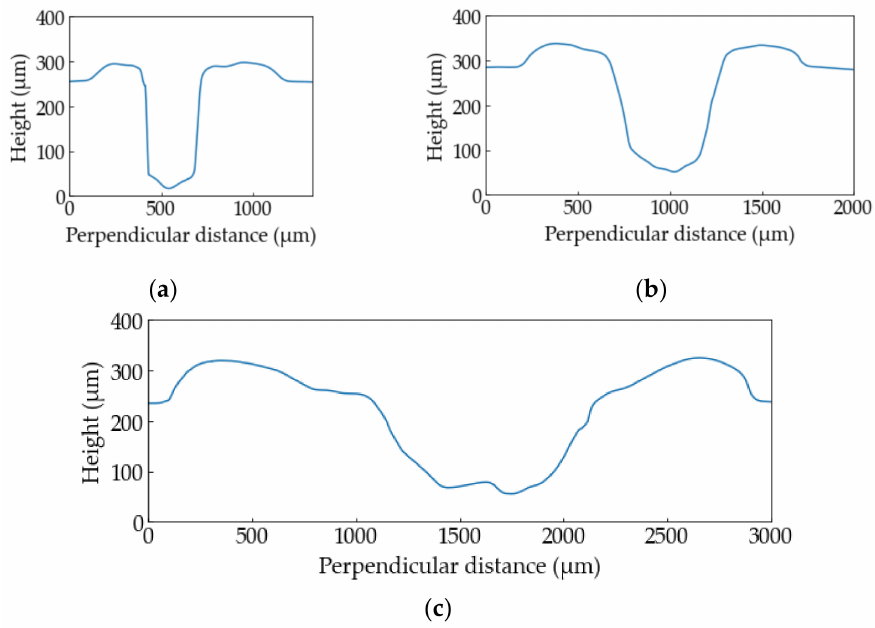
Figure 7. The height profiles of the PP samples: ( a ) E v = 3.8 × 10 10 J/m 3 , ( b ) E v = 9.5 × 10 10 J/m 3 , ( c ) E v = 38 × 10 10 J/m 3